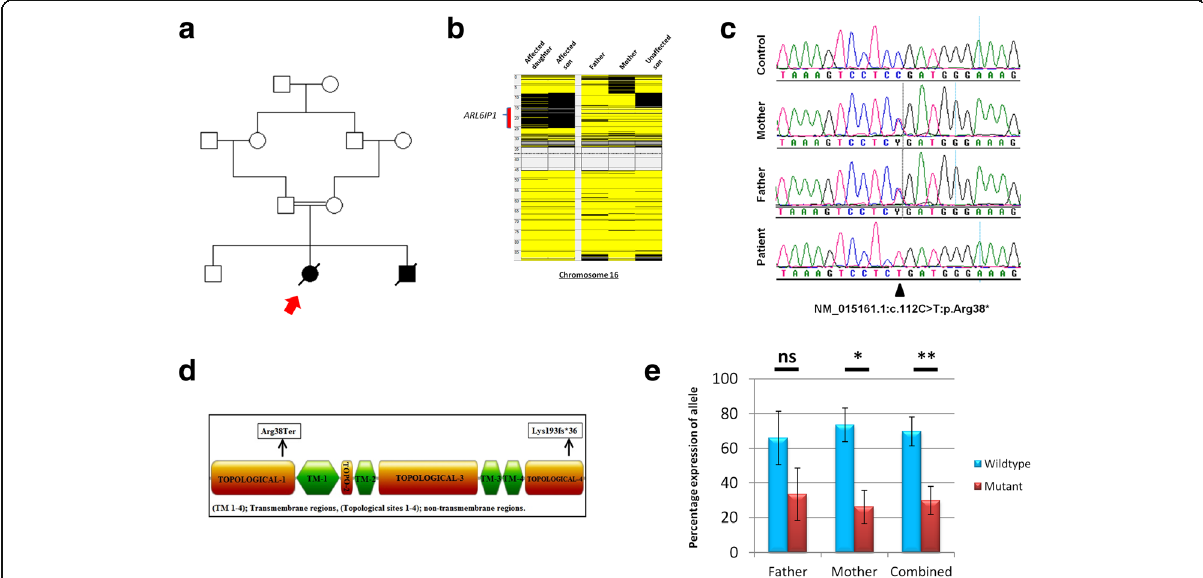
Fig. 1 a . Pedigree of the family from this study. The index case (whose DNA was subjected to WES) is indicated with an arrow. b AutoSNPa software showing block of homozygosity (black) of family on chromosome 16 encompassing the ARL6IP1 gene. Yellow regions indicate heterozygous SNPs. c Sequence electropherogram traces showing the mutation c.112C > T in one patient compared with both parents and a normal control. d Gene domains of ARL6IP1 showing mutations reported thus far. e Analysis of the wildtype vs mutant allelic expression for both parents, based on three independent low-cycle RT-PCR reactions cloned into TOPO vector. Asterisks indicate significance levels (* p < 0.05, ** p < 0.01, ns = not